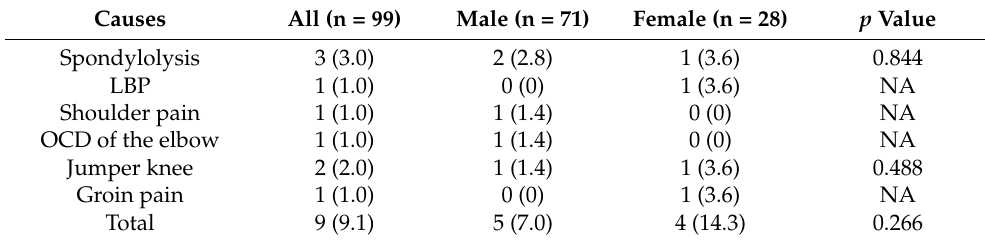
Table 2. The reasons why adolescent weightlifters received orthopaedic treatments.